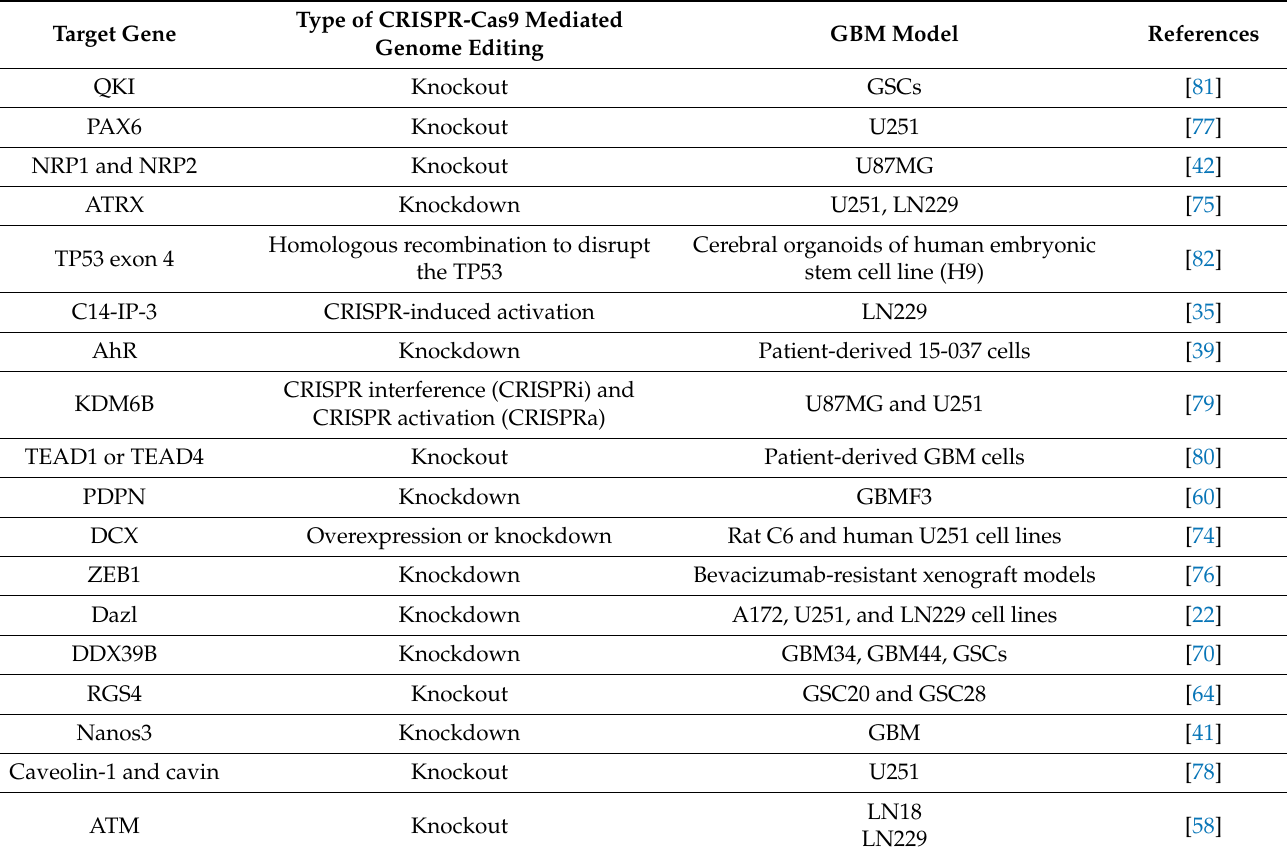
Table 5. CRISPR-Cas 9 mediated knockouts of migration-related genes in